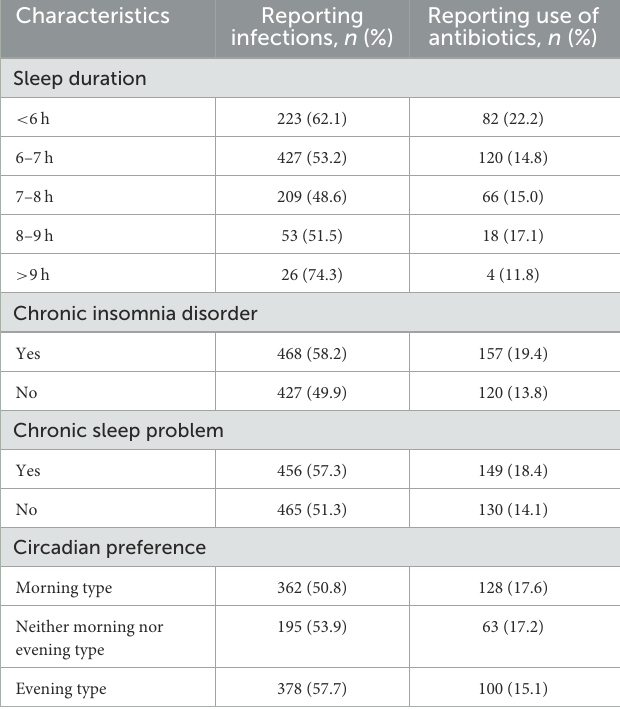
TABLE 2 Absolute risk of infection (any type) and antibiotic use among 1,848 patients visiting their GPs in the spring and fall of 2020.